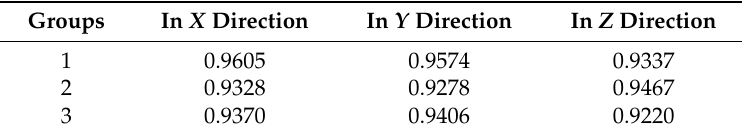
Table 1. Correlation coefficients for vibration with tool wear.